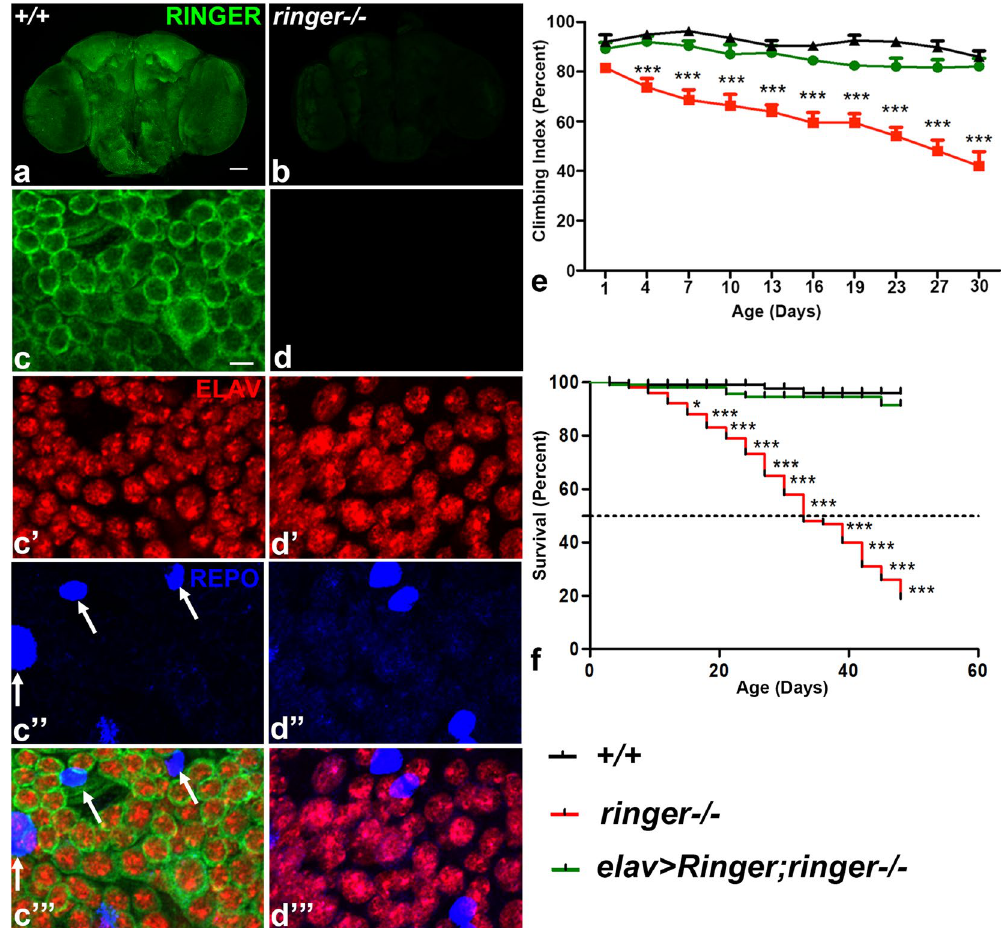
Figure 1. Ringer is expressed in neurons of adult Drosophila brain and loss of Ringer leads to locomotor disability and reduced lifespan. ( a , b ) Lower magnification confocal images of day 3 whole-mount adult brain of wild type ( a ) and ringer −/− ( b ) stained with anti-Ringer (green). ( c - d’’’ ) Higher magnification confocal images of adult brains of wild type c – c’’’ and ringer −/− ( d - d’’’ ) stained with anti-Ringer (green), ( c , c’” and d , d’” ), anti-ELAV (red), ( c’ , c’” and d’ , d’” ) and anti-REPO (blue), ( c” , c’” and d” , d’” ). ( e ) Climbing ability of wild type (black), ringer −/− (red) and elav > Ringer;ringer −/− (green) rescue flies. n = 50 flies per genotype. Statistics was done using two-way ANOVA, ringer −/− *** p = 0.0001, elav > Ringer;ringer −/− p = 0.6883. ( f ) Lifespan analysis of wild type (black), ringer −/− (red) and elav > Ringer;ringer −/− (green) rescue flies. n = 200 flies per genotype. Kaplan-Meyer curve, log rank test, ringer −/− *** p < 0.0001, elav > Ringer;ringer −/− p = 0.317. Scale bars: ( a,b ) = 20 µm, ( c - d’” ) = 5